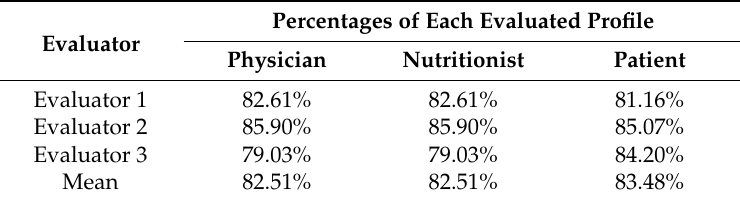
Table 11. Results of the SIRIUS heuristic